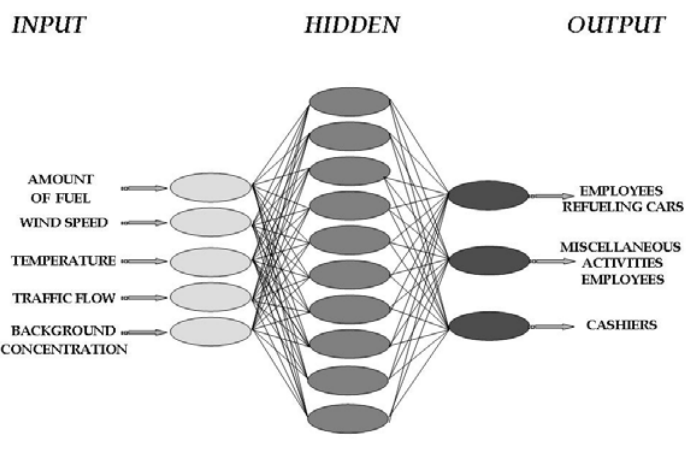
Figure 3 . Structure of the proposed